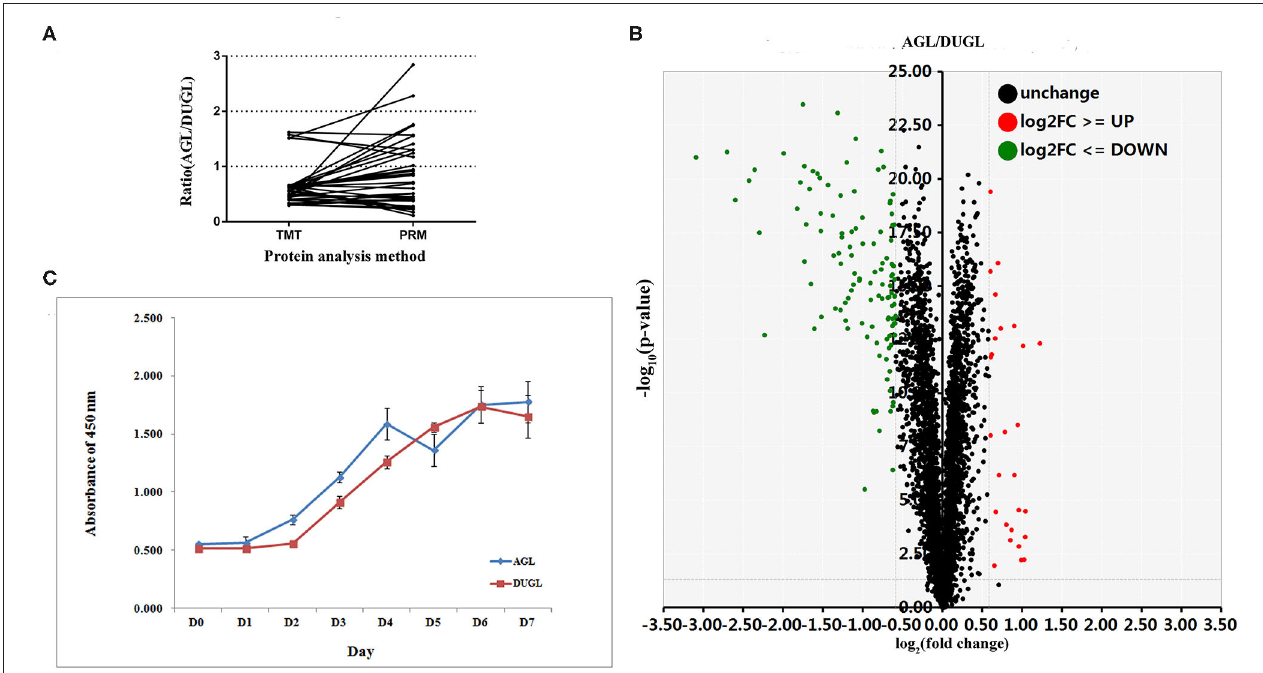
FIGURE 3 | (A) PRM verification results of the selected DAPs (AGL/DUGL); (B) Growth curves of FD-LSC-1 cells cultured in the DUGL or AGL; (C) Volcano plot (red, upregulated DAPs; black, unchanged DAPs; green, downregulated DAPs [AGL/DUGL]). DAPs, differentially abundant proteins; DUGL, deep underground laboratory; AGL, above-ground laboratory; PRM, parallel reaction monitoring.